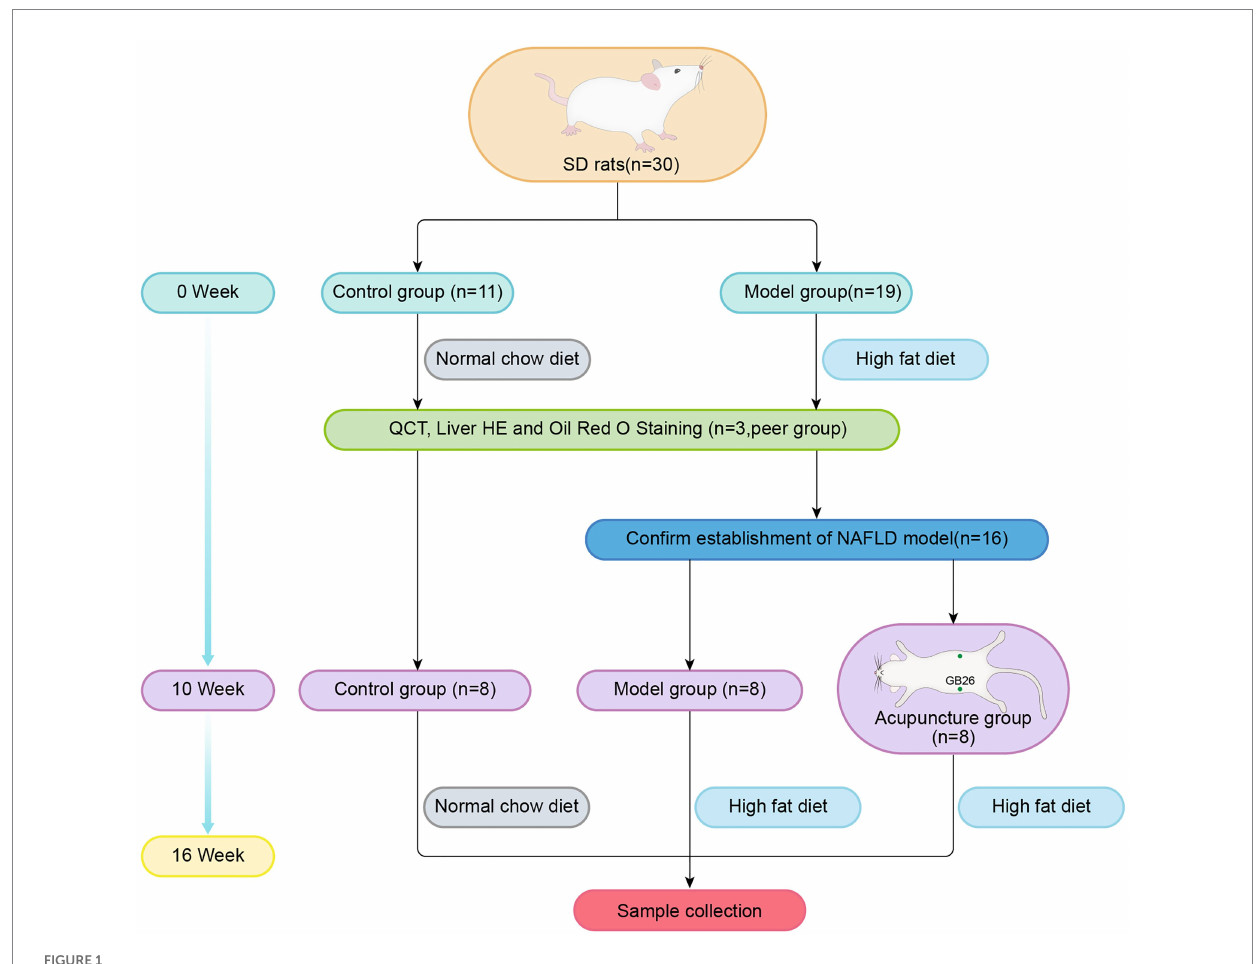
FIGURE 1 Groups and experimental